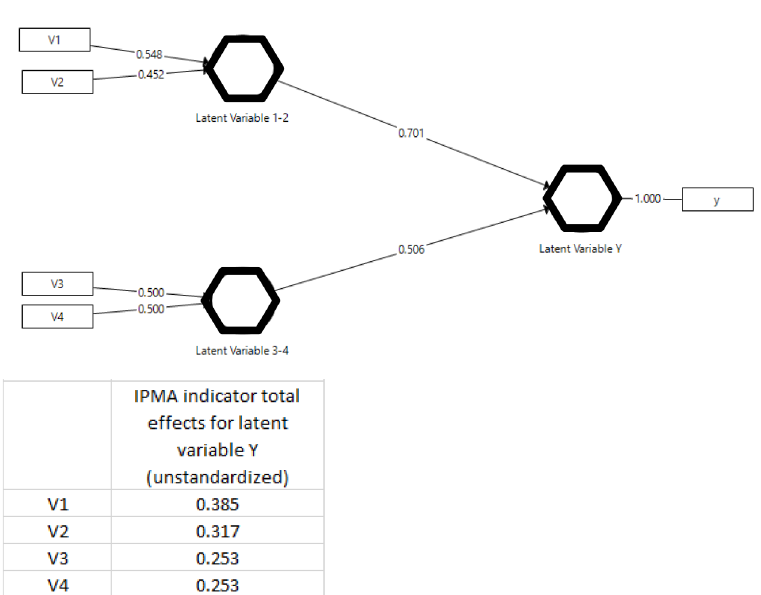
Figure 5. “Unstandardised path coefficients” and “rescaled outer weights” with the IPMA procedure in